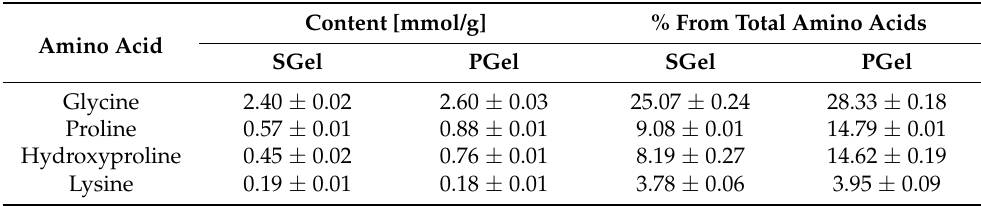
Table 1. Glycine, proline, hydroxyproline, and lysine contents of salmon and porcine gelatins. Values are presented as average ± standard deviation.